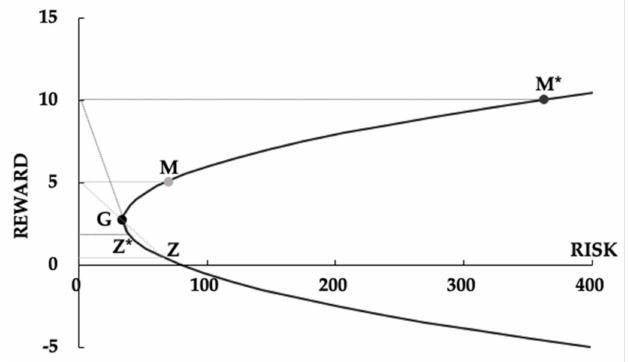
Figure 5. CAPM vs. specified threshold reward.